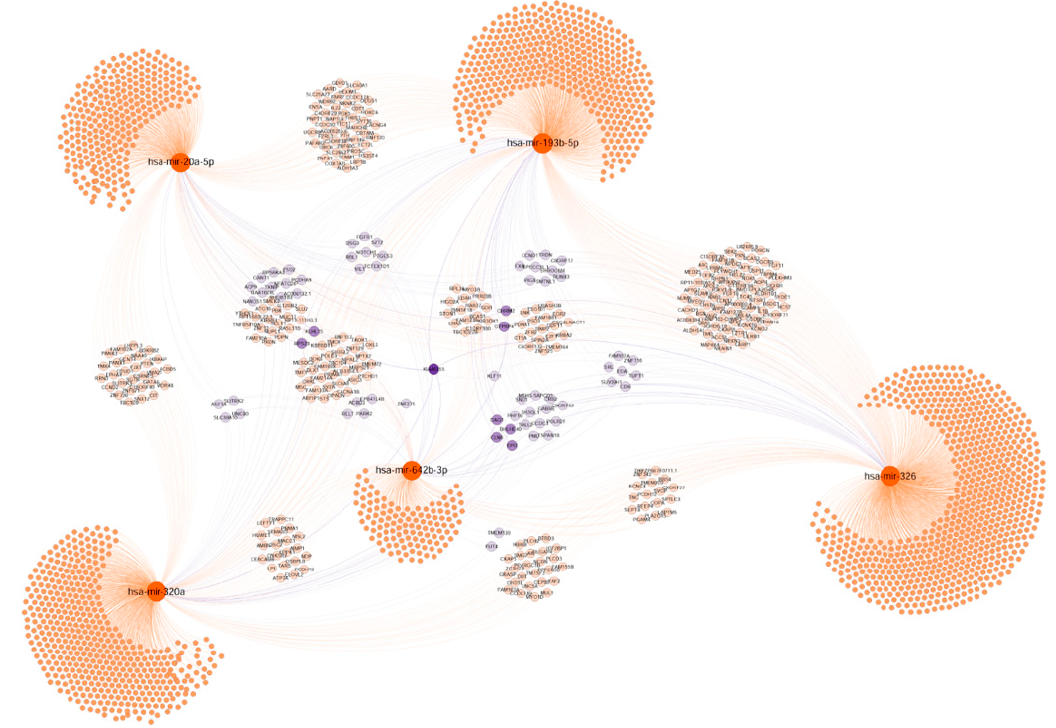
Figure 8. Target genes network of validated miRNAs associated with tumour invasion and progression. Selected miRNAs are highlighted. Genes with at least two potential interactions were labelled. Genes with just one connection are unlabelled. Colour nodes of regulated genes are proportional to node degree (number of connections).